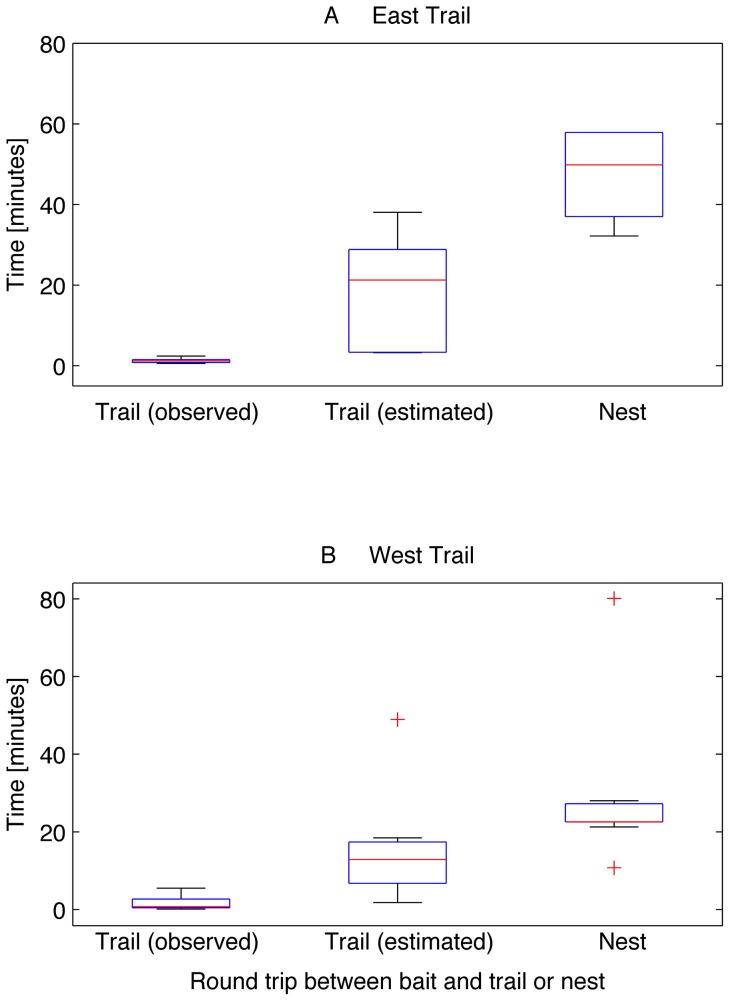
Round trip ‘bait-trail-bait’ and ‘bait-nest-bait’ durations.The time to complete a round trip from the bait to the nest and back is significantly longer (p<0.001) than the observed and estimated bait-trail-bait time for both East and West trails. Box plots represent the duration for (A) seven measurements on the East trail, and (B) seventeen measurements on the West trail. The central line on each box is the median. The box edges are the 25th and 75th percentiles. The whiskers extend to the most extreme data points that are not considered outliers which are plotted individually as “+”.